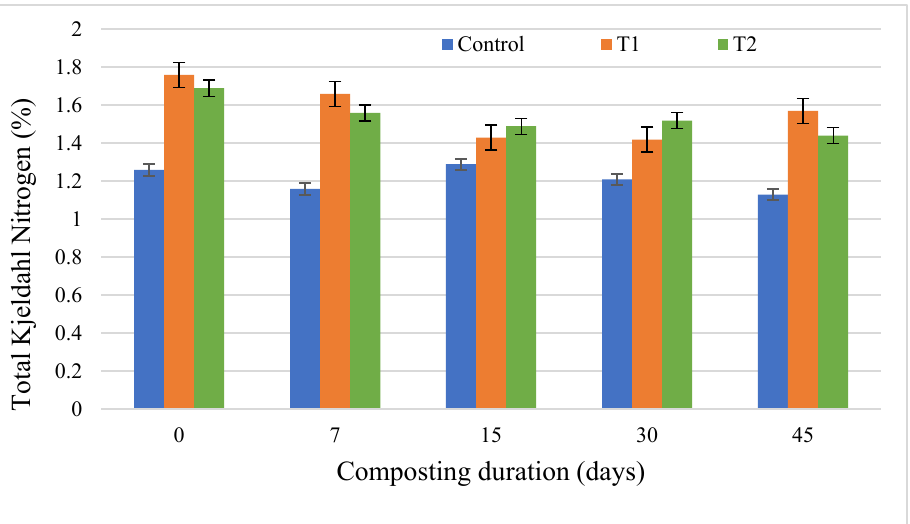
Figure 8. TKN level changes in control, T1, and T2 samples at 0, 7, 15, 30, and 45 days.